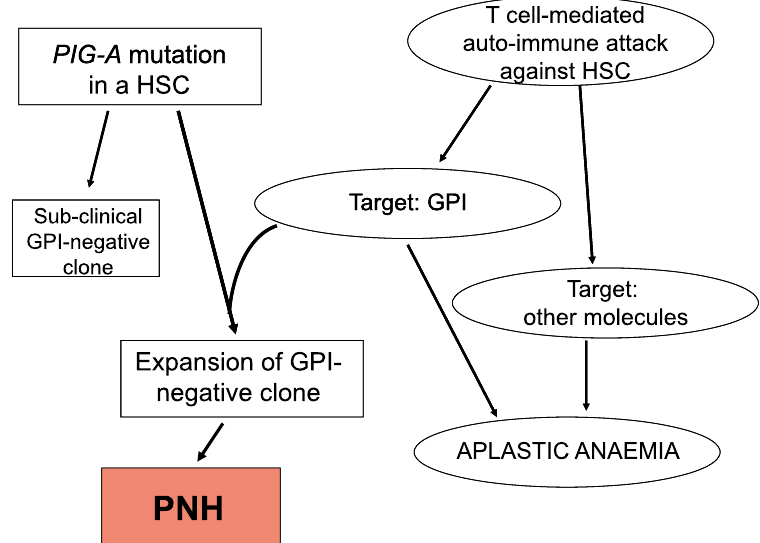
Figure 3. The dual pathogenesis of paroxysmal nocturnal hemoglobinuria (PNH). The diagram shows, on the right-hand side, the presumed pathogenesis of aplastic anemia (AA): a T-cell-mediated autoimmune attack damages hematopoietic stem cells (HSCs). The target of the auto-reactive T cells may be the glycosylphosphatidylinositol (GPI) molecule or another molecule expressed on HSCs. On the left-hand side, an inactivating mutation of the PIG-A gene in a HSC produces a GPI-negative hematopoietic clone. In the absence of the PIG-A mutant clone, the autoimmune attack, even if GPI is targeted, produces AA. In the absence of the autoimmune attack, a PIG-A mutant clone will be of no consequence (subclinical). Only if both a PIG-A mutant clone and a GPI-targeted autoimmune attack co-exist will the mutant clone expand and cause clinical